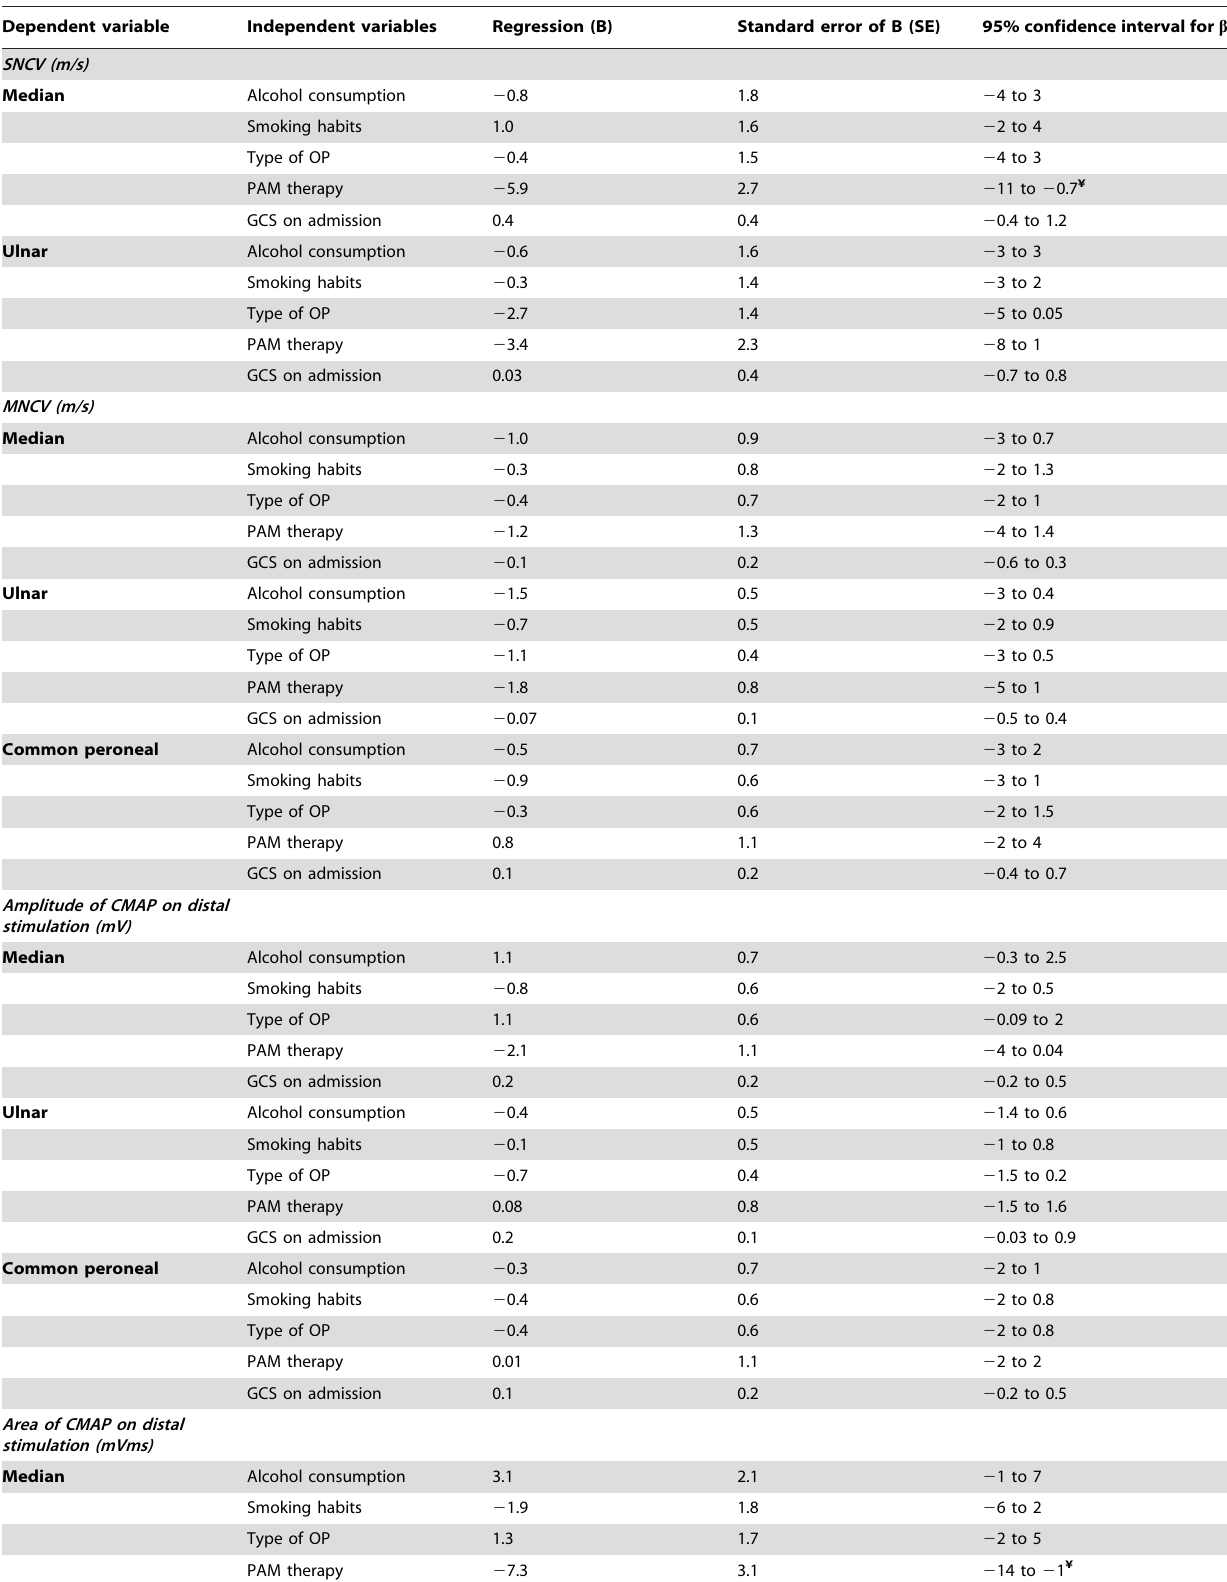
Table 6. Sensory and motor nerve conduction studies - multiple linear regression for